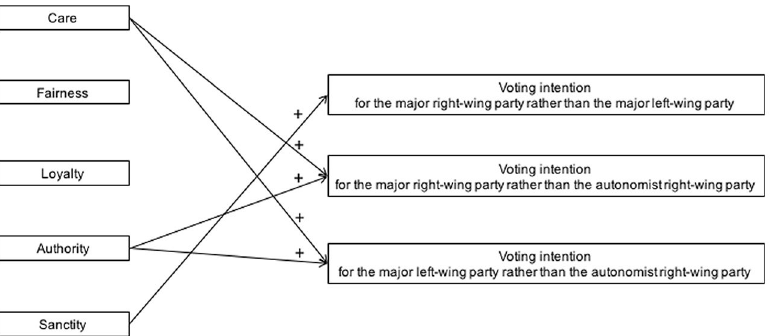
Figure 2. The association between distinct moral foundations and voting intention in fictitious national elections, Study 1. Visualization of the main results obtained in regression analyses, controlling for ideological